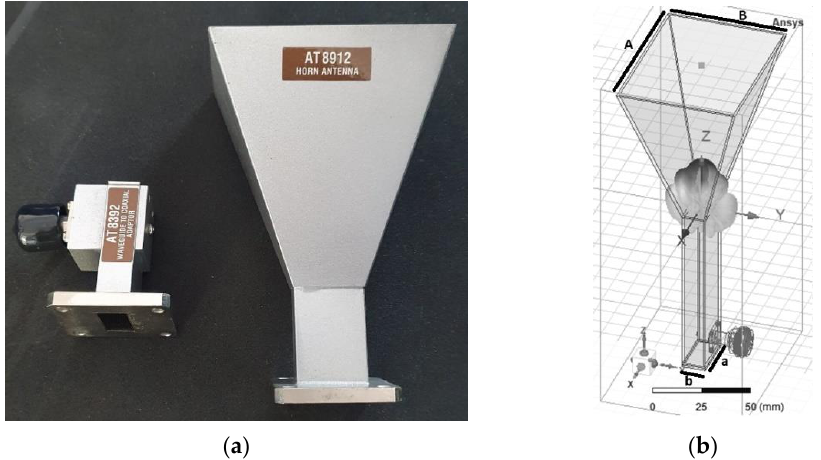
Figure 6. Pyramidal horn antenna: radiator and coaxial-to-waveguide adapter ( a ), and simulation model ( b ).